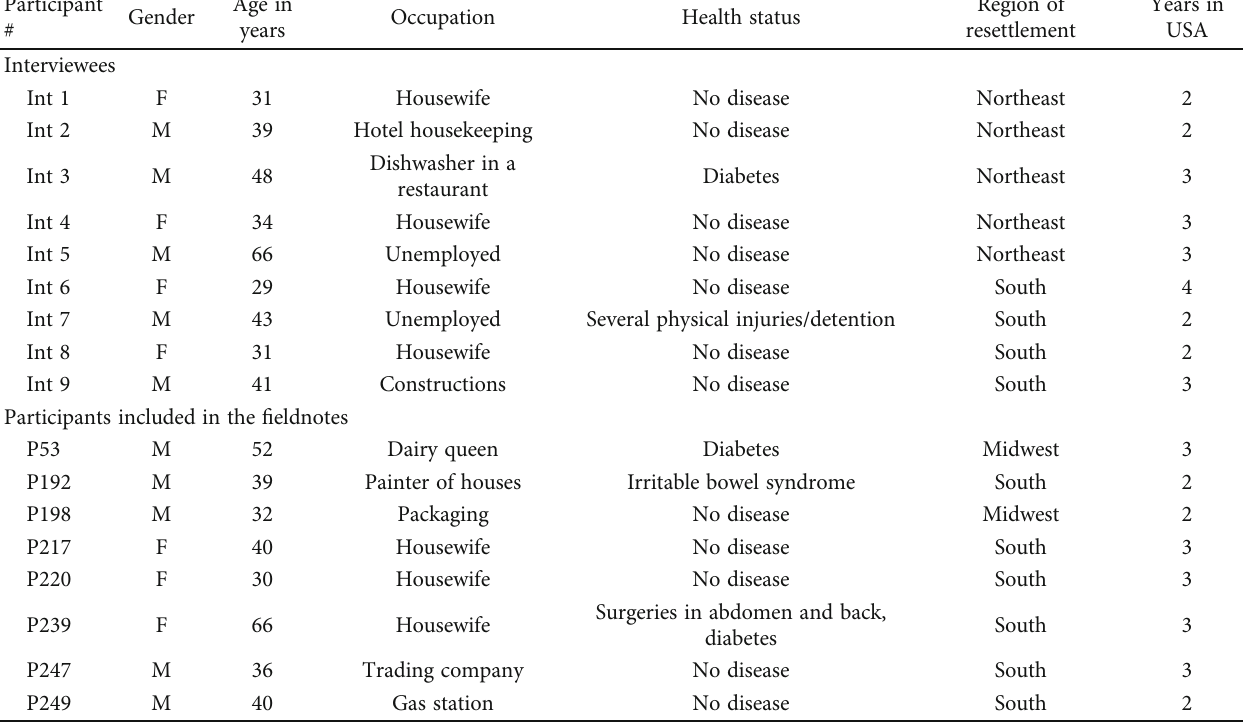
Table 3: Characteristics of participants in the semistructured interviews and fi eldnotes.